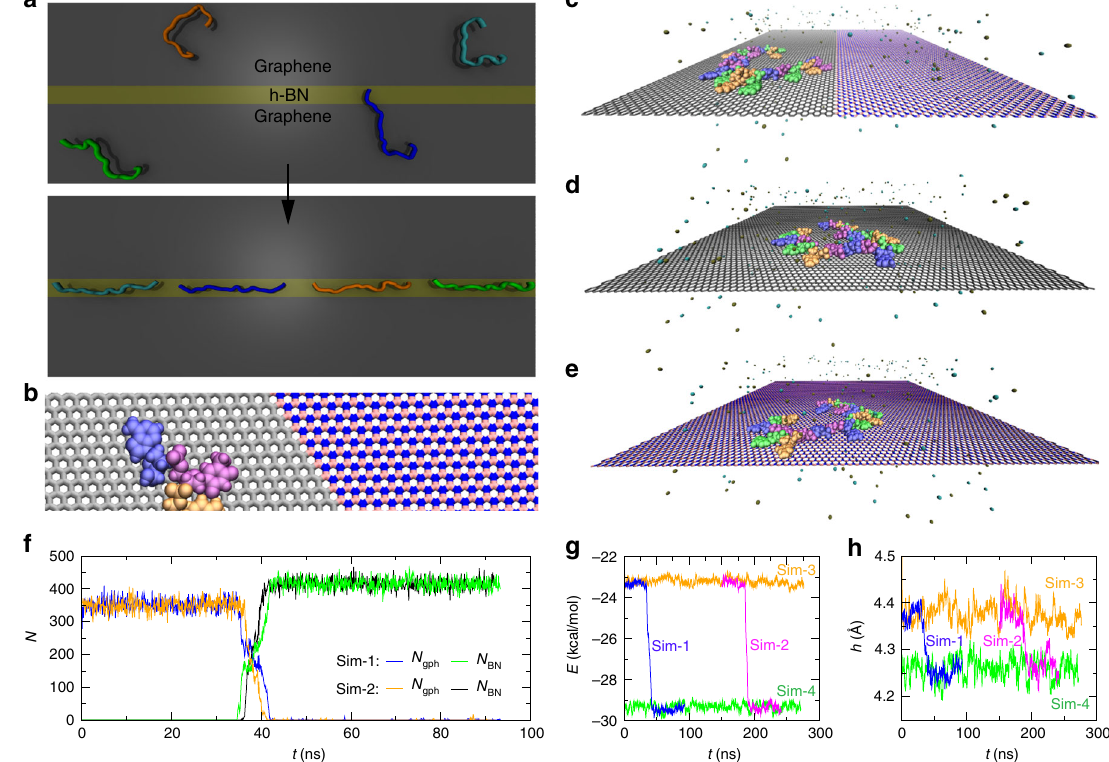
Fig. 1 ssDNA dynamics on 2D materials: graphene, h-BN, and their in-plane heterostructure. a An illustration on how ssDNA can be spontaneously stretched on an in-plane graphene/h-BN/graphene heterostructure. b An enlarged view of an ssDNA fragment near the graphene/h-BN boundary, with atomic details. Carbon atoms in graphene are colored in gray while boron and nitrogen atoms in h-BN are colored in pink and blue, respectively. c – e Simulation systems of ssDNA on the graphene/h-BN heterostructure, graphene, and h-BN, respectively. A 20-base-long ssDNA is colored according to base types: A (blue), T (purple), C (orange), and G (green). Water is not shown; K + (tan) and Cl − (cyan) ions are shown as van der Waals spheres. 2D materials are in the stick representation. f Number of atoms in the graphene/h-BN heterostructure that are within 3.5 Å of ssDNA, during simulations. g van der Waals interaction energies (per nucleotide) between ssDNA and different 2D materials. Results from Sim-2 were shifted by 150 ns for clarity. h Heights of ssDNA (centers of mass) above different 2D